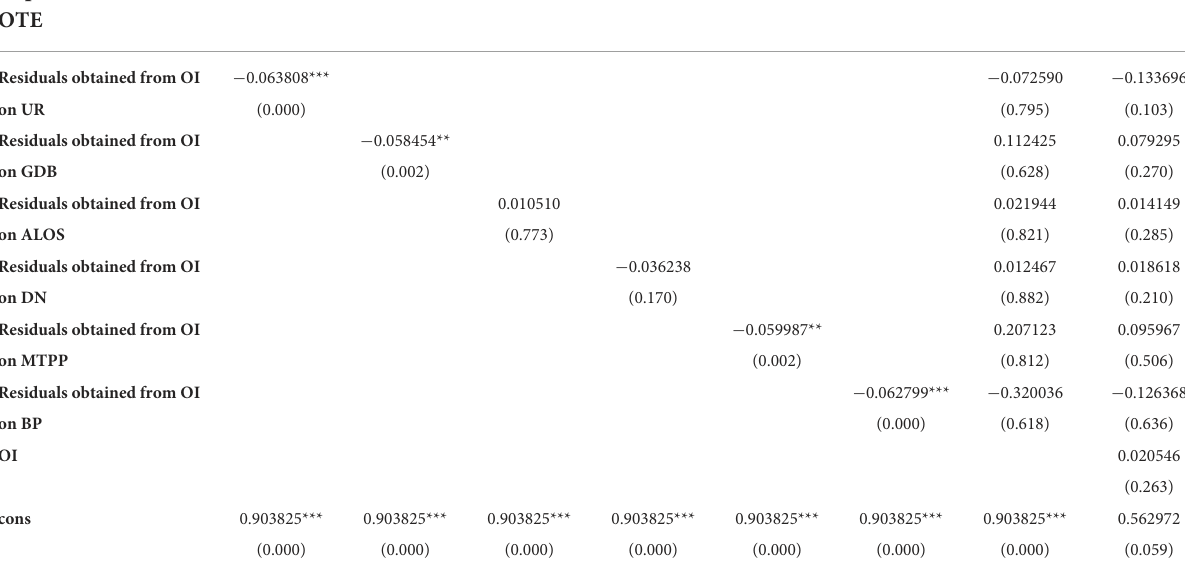
TABLE 10 Results of bootstrapping truncated regression for secondary hospitals: estimations of the residuals from OI.